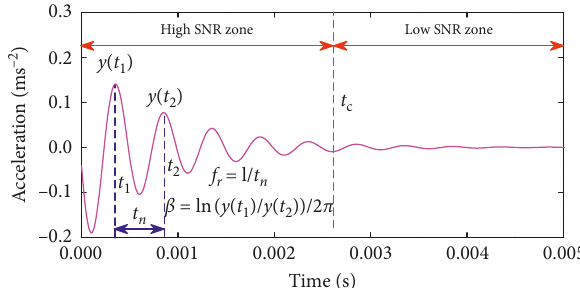
Figure 6: SNR distribution in an impulse